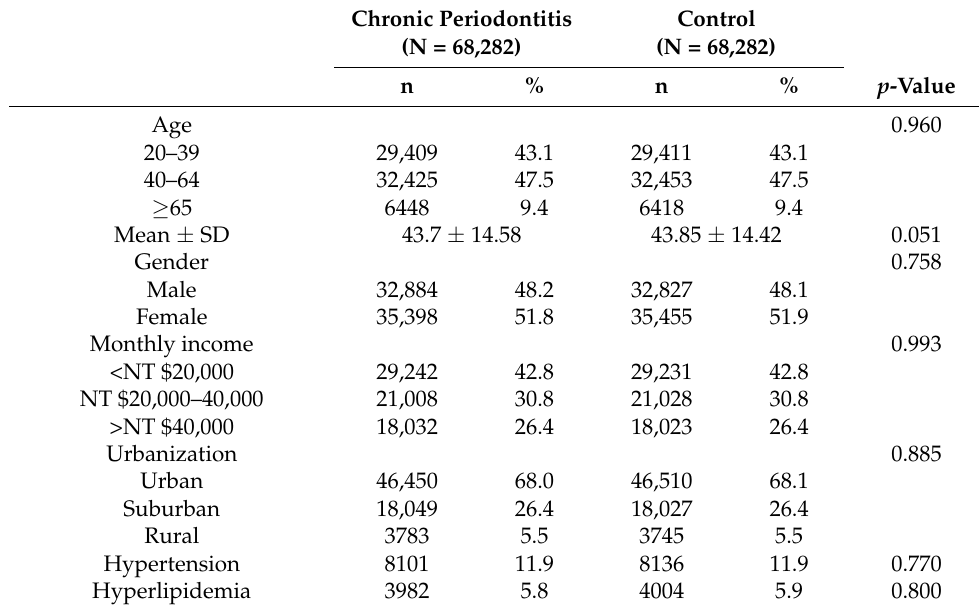
Table 1. Demographic data of matched study